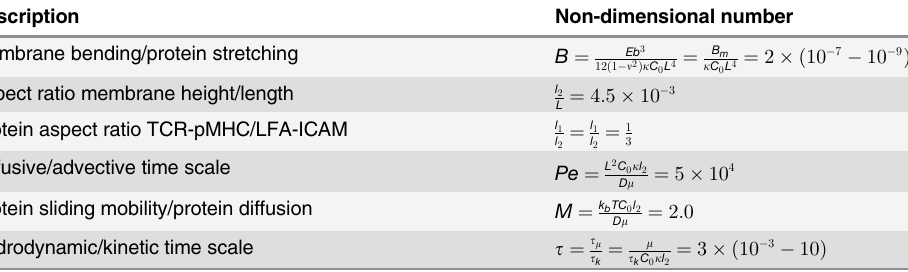
Table 2. By substituting the scaled variables in Eqs 1 – 4; p ( x , y , t ) = p * ( x , y , t ) p 0 = p * ( x , y , t ) C 0 κ l 2 , h ( x , y , t ) = h ( x , y , t ) * l above. These non-dimensional numbers characterize the relative influence of membrane mechanics, protein kinetics, geometry and